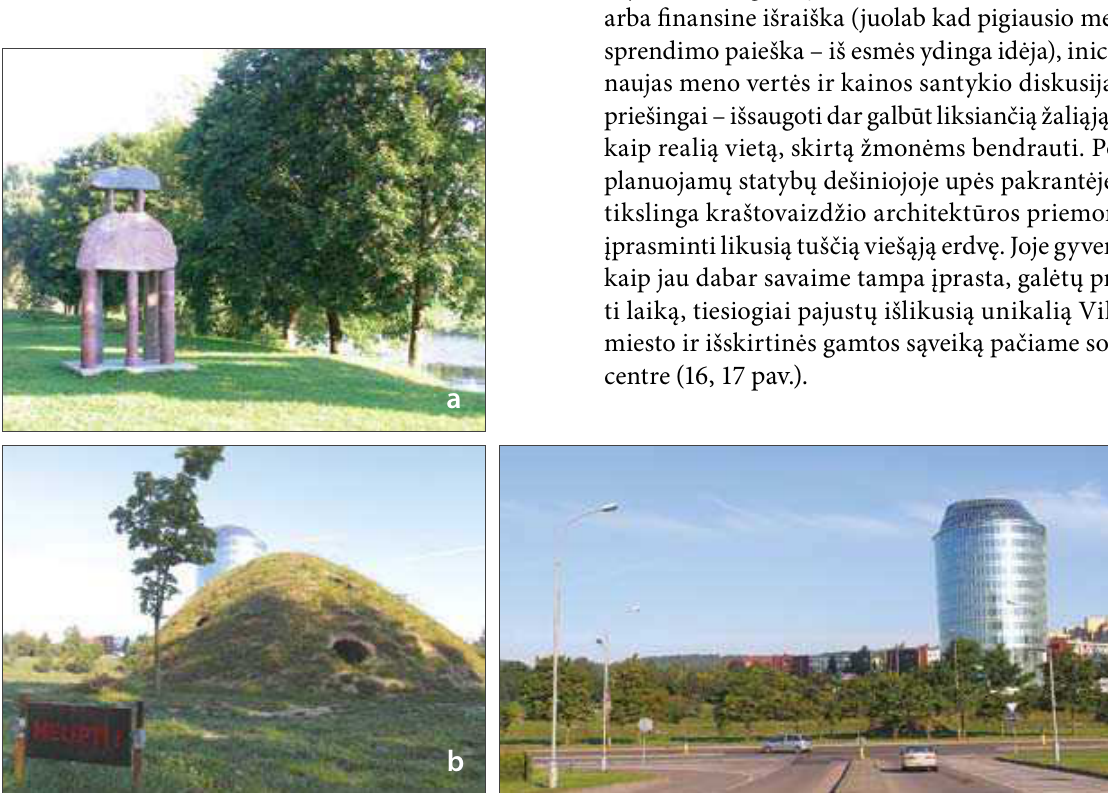
Fig. 15. Sculpures created on the Neris riverside for Vilnius – the capital of european culture (authors: V. Urbanavičius, M.Navakas, r. antinis). “Puskalnis” erected on the street axis could block the future bridge to Žvėrynas (a, b,